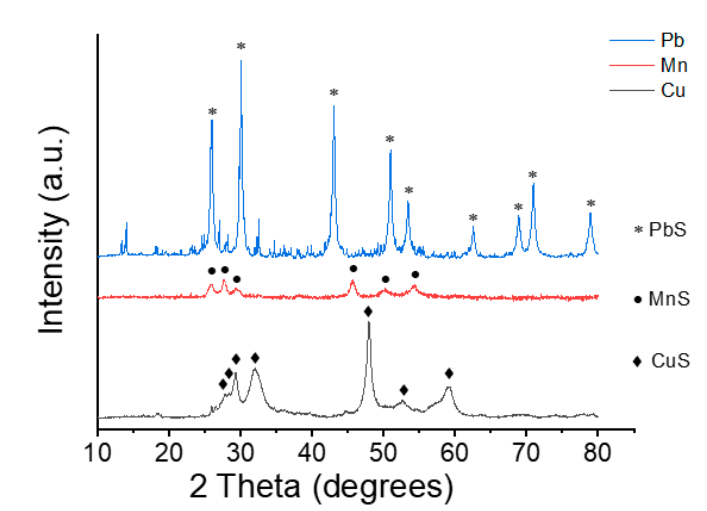
Figure 3. XRD patterns of PbS, MnS, and CuS precipitates.